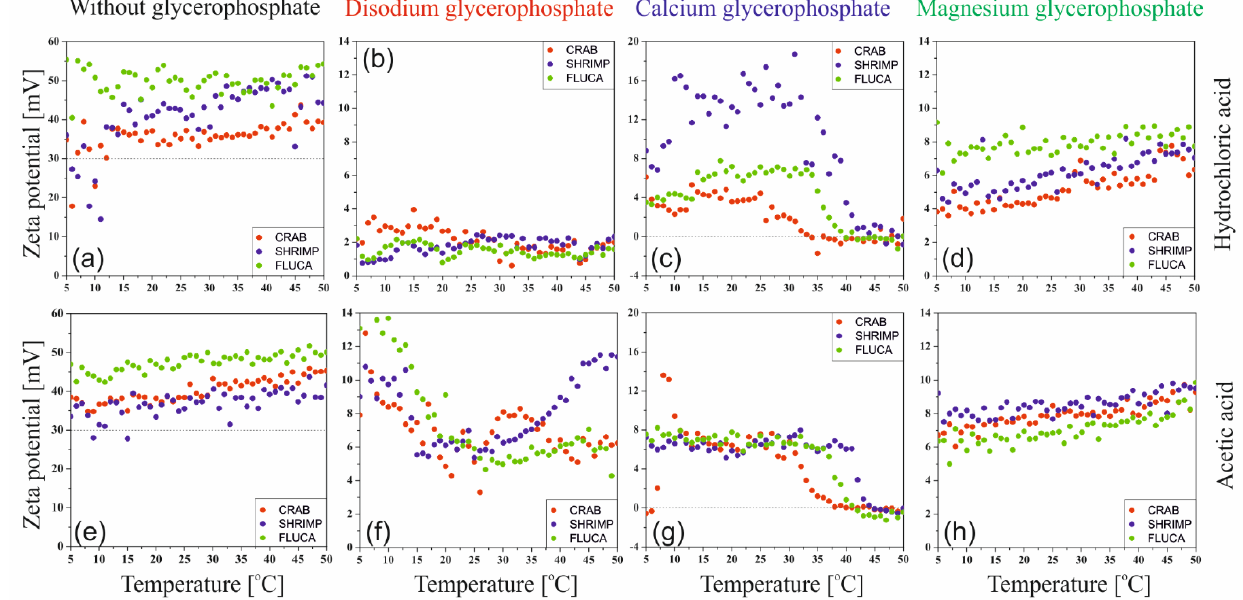
Figure 2. Changes in the Zeta potential value determined during heating for chitosan chlorides ( a – d ) and acetates ( e – h ) without and with the addition of various glycerophosphate salts.